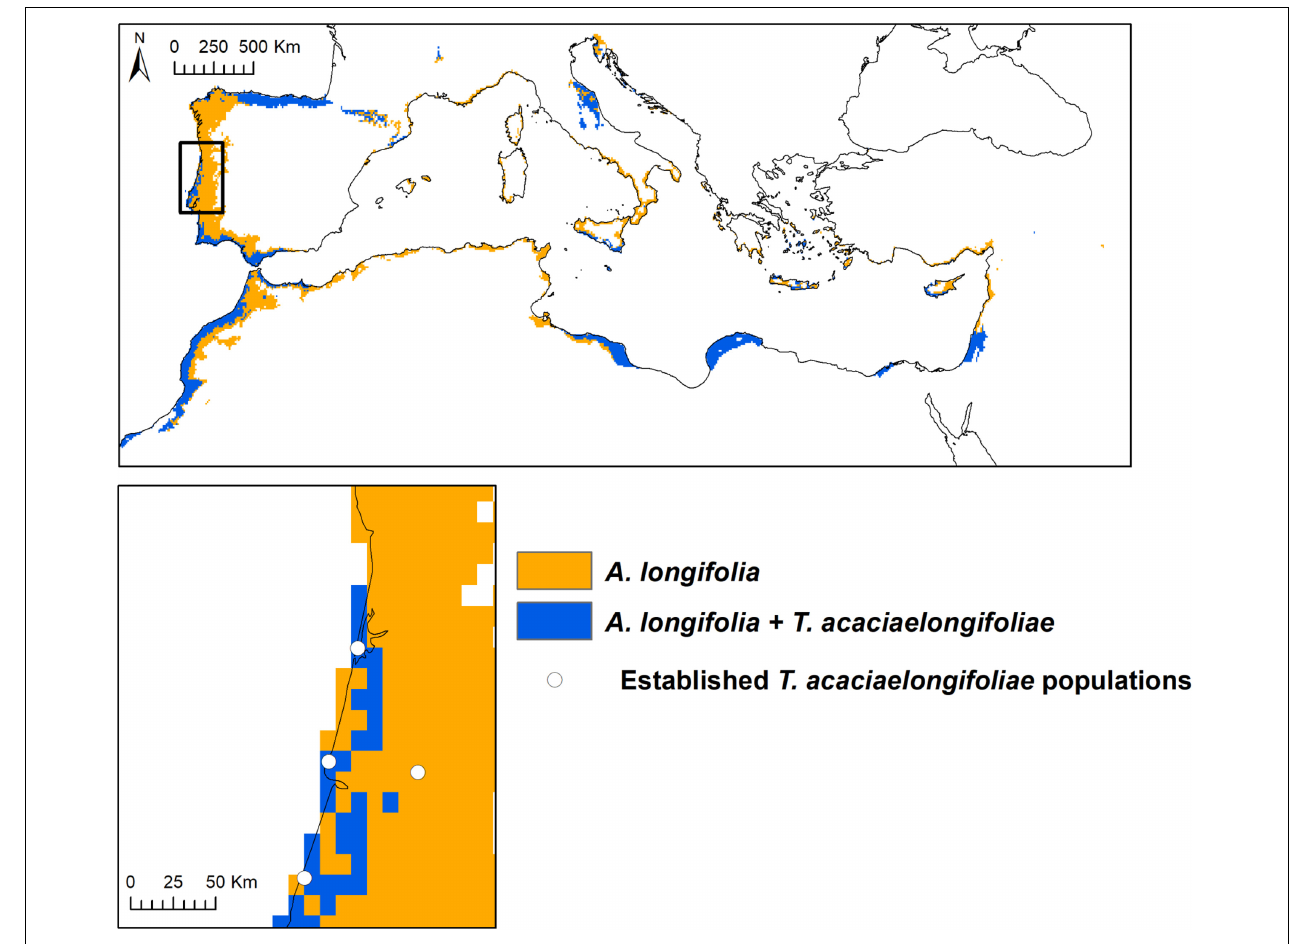
FIGURE 3 | Spatial overlap between model predictions of suitability for Acacia longifolia and Trichilogaster acaciaelongifoliae in the Mediterranean region. Trichilogaster acaciaelongifoliae model was constrained to areas of predicted suitability for A. longifolia to prevent classification of suitability in areas where the species cannot persist due to lack of its host plant. Bottom: Populations of T. acaciaelongifoliae already established in Portugal as of